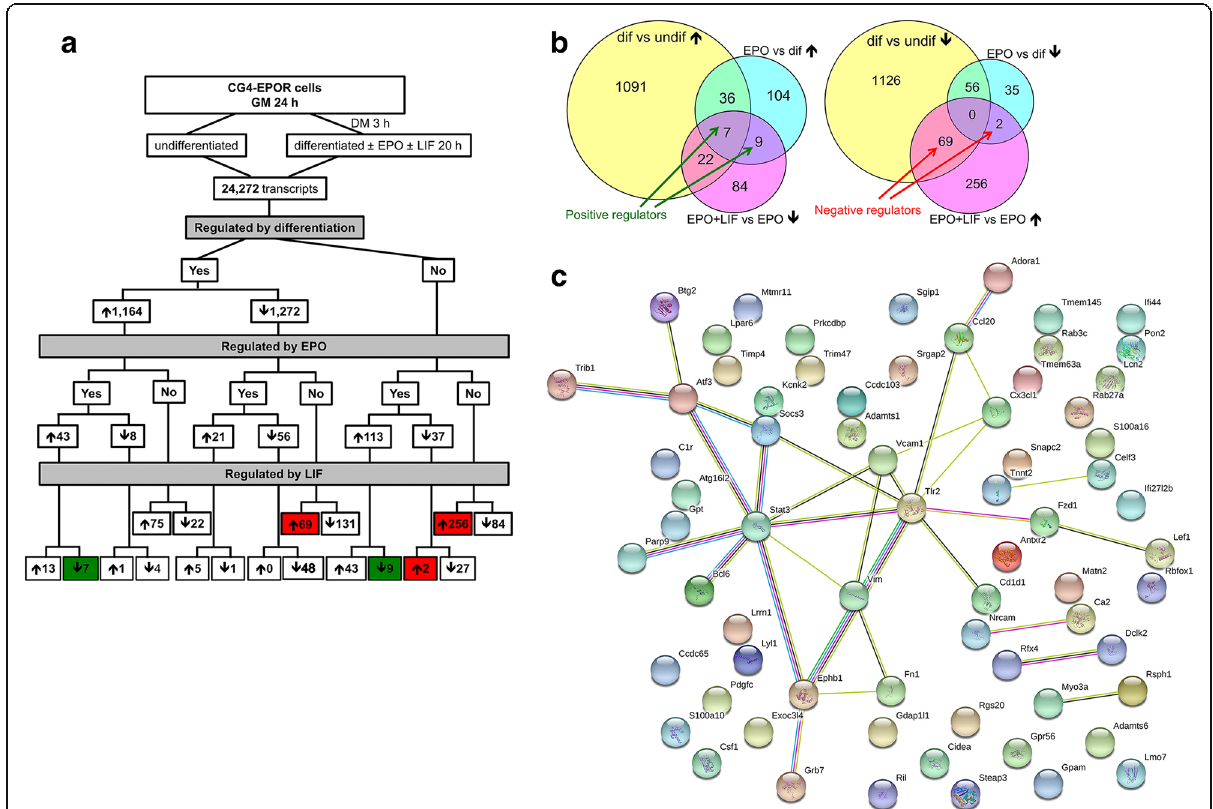
Fig. 3 Genes regulated by LIF at 20 h. Cells cultured for 1 day in GM were switched to DM; after 3 h EPO with or without LIF was added for 20 h. a Flow chart. Genes regulated by differentiation, EPO and LIF were selected as in the legend to Fig. 2. Positive regulators induced by EPO and inhibited by LIF are highlighted in green (16, of which 7 induced also by differentiation). Negative regulators induced by LIF and unchanged by differentiation or EPO (256) or decreased by differentiation (69) or by EPO (2) are highlighted in red. b Venn diagrams showing positive regulators inhibited by LIF (left; EPO-induced genes unchanged or induced by differentiation, 9 and 7 respectively, green arrows) and negative regulators induced by LIF (right; 256 unchanged by differentiation or EPO; 69 and 2 decreased by differentiation or EPO respectively, red arrows). The genes changed in opposite directions by EPO and differentiation are not included in b . These are: 8 genes increased by differentiation but decreased by EPO and 21 genes increased by EPO but decreased by differentiation ( a ). In addition, the left diagram (positive regulators) does not include the genes decreased by LIF but also decreased by differentiation or EPO (4 + 1 + 48 + 131 + 27 = 211; a ). The right diagram (negative regulators) does not include the genes increased by LIF but also increased by EPO or differentiation (13 + 1 + 75 + 5 + 43 = 137; a ). Dif, differentiated; undif, undifferentiated. c Gene-gene interaction network of the putative negative regulators increased by LIF at 20 h. All the genes increased by LIF and decreased by differentiation alone (69 genes, a ) or by EPO alone (2 genes, a ) were analysed with the STRING software as described in the legend to Fig. 2. The full list of all the 71 genes is reported in Additional file